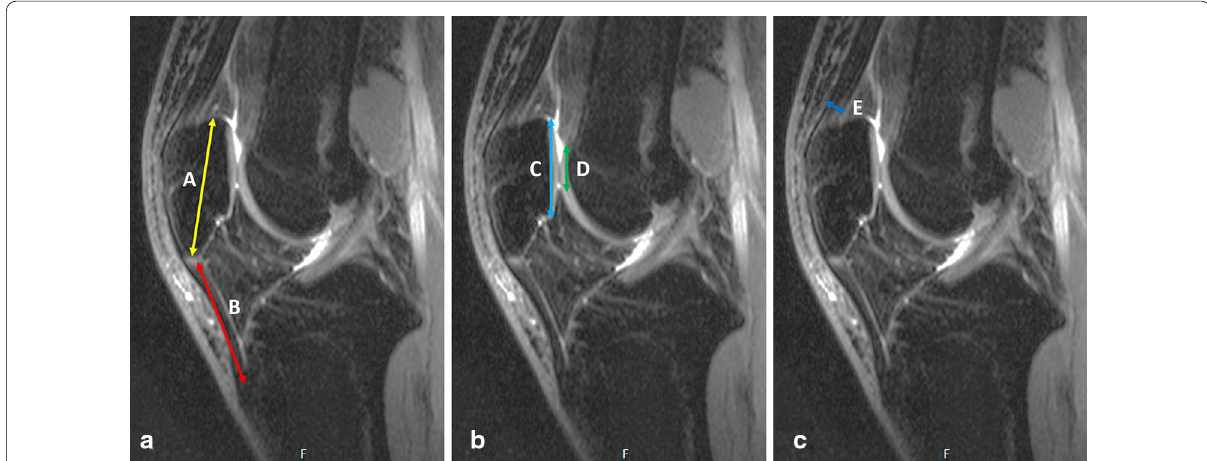
Fig. 4 a The ratio of patellar tendon length (Line B) to longest diagonal length of patella (line A) was calculated as the Insall–Salvati ratio. b The ratio of length of articular surface of patella (line C) to length of opposing femoral articular surface (line D) was calculated as patellotrochlear index. c The distance between the most anterior and most posterior border of the quadriceps tendon just over the patellar attachment was measured and recorded as quadriceps tendon thickness. All measurements were performed on sagittal fat-saturated, proton-density-weighted MRI